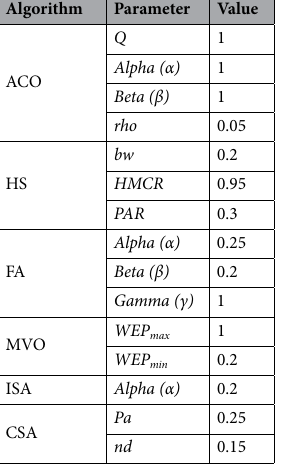
Table 2. The parameter settings of the optimization algorithms.